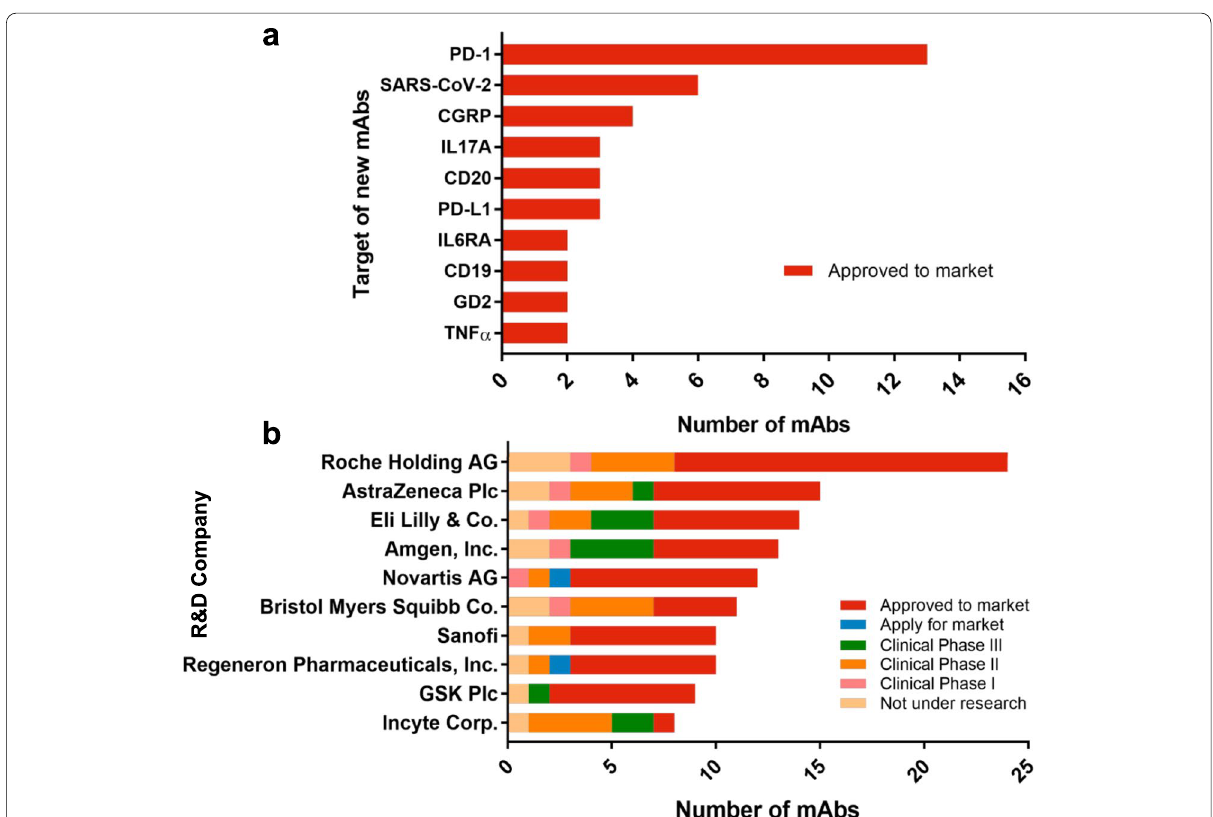
Fig. 3 Histogram of the number of mAbs for the top ten targets and R&D companies. a The top ten targets of mAbs approved to market for use from 2021. Data were collected from January 1, 2021, to August 1, 2022. b The top ten institutions and the distribution of their drug R&D stages. R&D, research and development. Figure based on data publicly available as of August 1, 2022, and available at https:// pharm snap. zhihu iya.